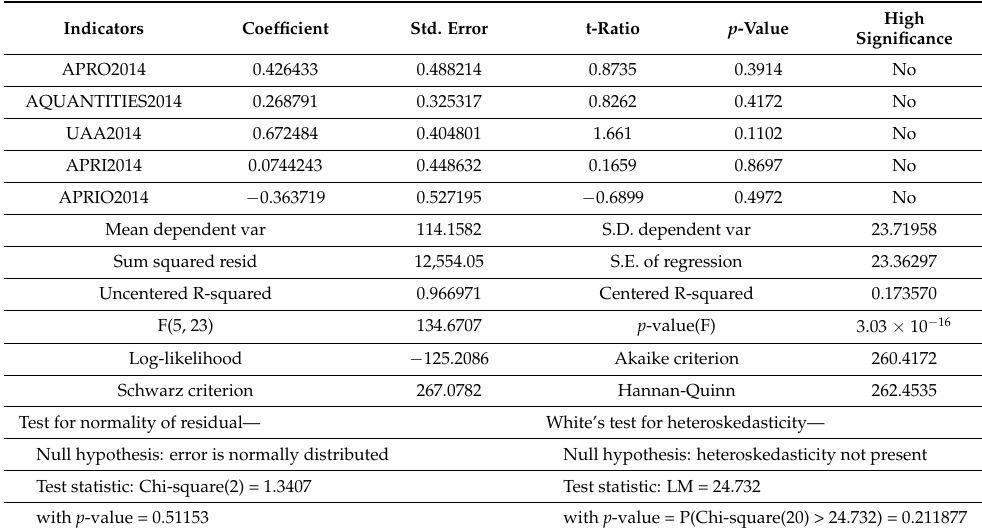
Table 4. Model 2014: OLS, using observations 1–28 (Dependent variable: